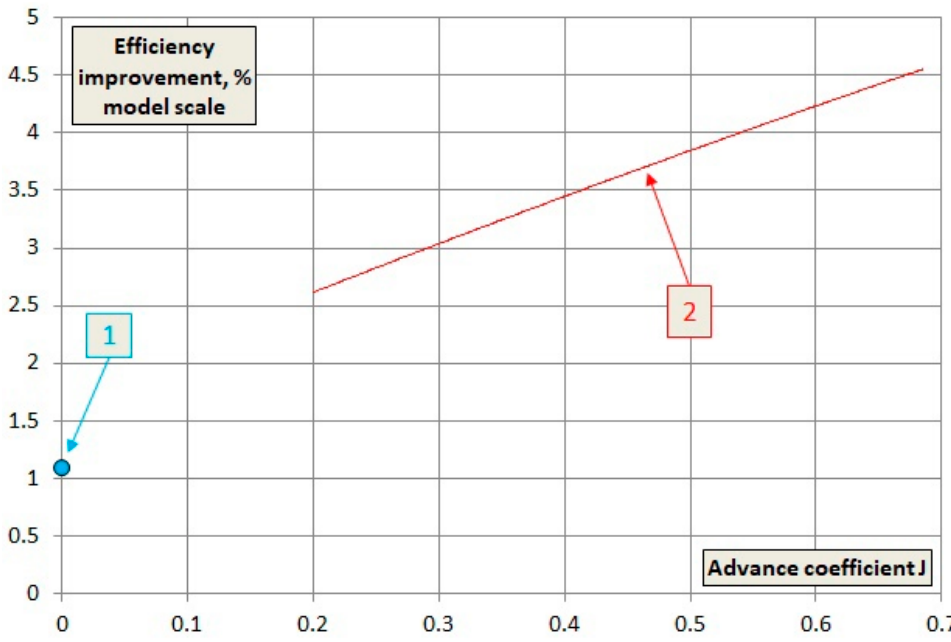
Figure 16. Relative comparison of the efficiency (performance factor) of icebreaking propellers with a sharp profile and a blunt profile of IK82 type (see Figure 1). 1—ratio K T / K Q 2/3 in bollard mode; 2—ratio η 0 for design